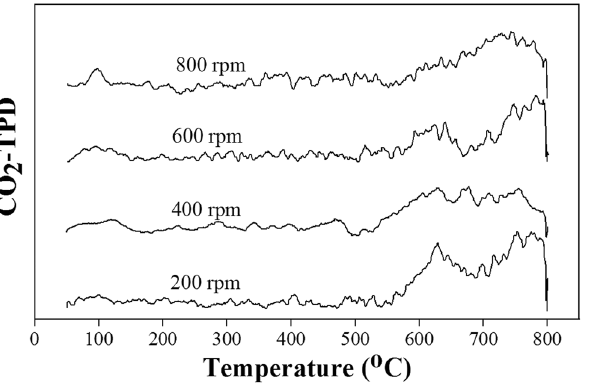
Figure 6: CO 2 desorption of CeO 2 synthesized using a 400 rpm stirring rate at 3% oxalic concentration.